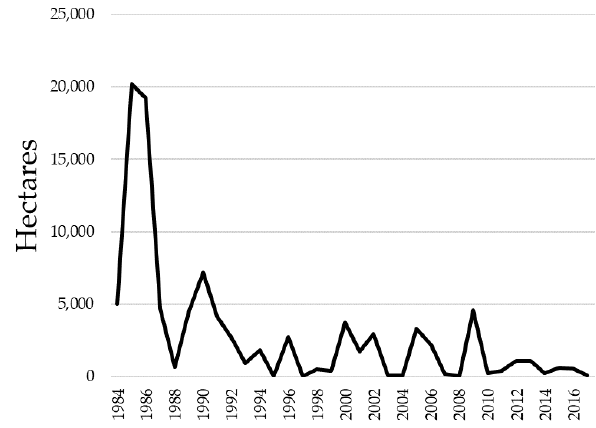
Figure 11 . Burned surface area in hectares (1984 – 2017). Figure 11. Burned surface area in hectares